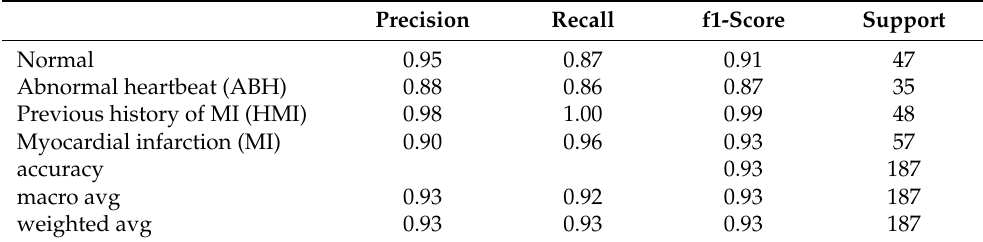
Table 6. Classification report for MobileNet V2 transfer